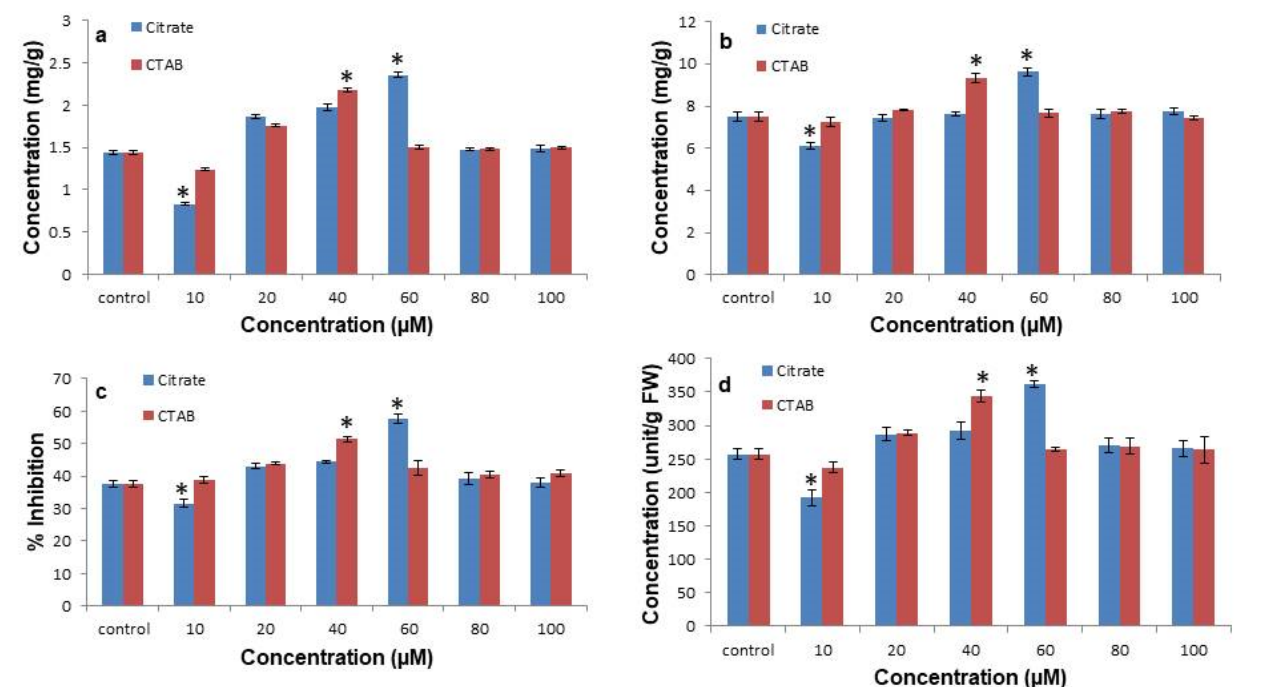
Figure 5. The impact of citrate-AuNPs and CTAB-AuNPs on the in vitro enhancement of antioxidant activity. ( a ) The effect of citrate-AuNPs and CTAB-AuNPs on the total phenolic content; ( b ) effect of citrate-AuNPs and CTAB-AuNPs on the total flavonoids; ( c ) effect of citrate-AuNPs and CTAB-AuNPs on the DPPH inhibition; ( d ) effect of citrate-AuNPs and CTAB-AuNPs on the SOD enzyme activity. Error bar represents the standard error of three biological replicates. * Indicates significantly reduced and enhanced concentrations in comparison to the control.